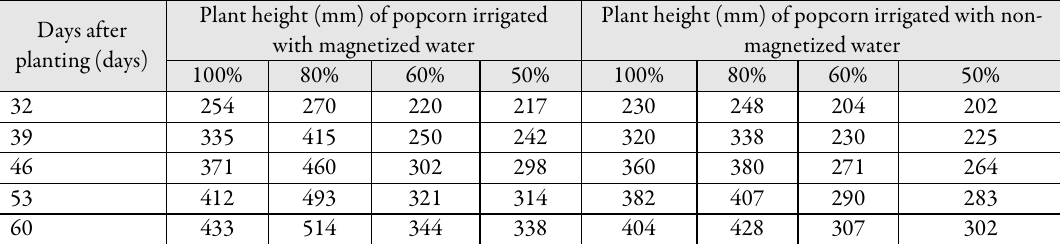
Table 4. Growth of the popcorn plant